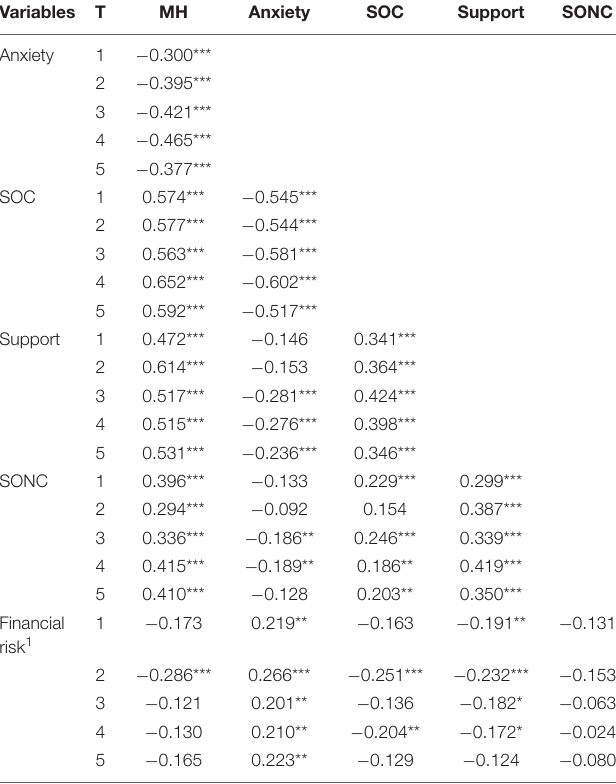
TABLE 2 | The correlations between main variables of the research, separately for each phase ( n = 198). Variables T MH Anxiety SOC Support